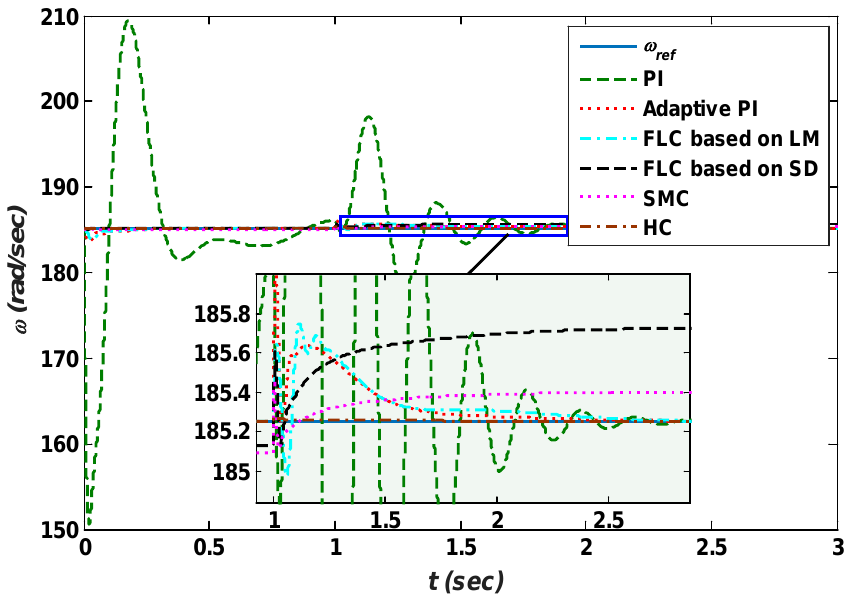
Figure 23. The speed loop parameter variations.